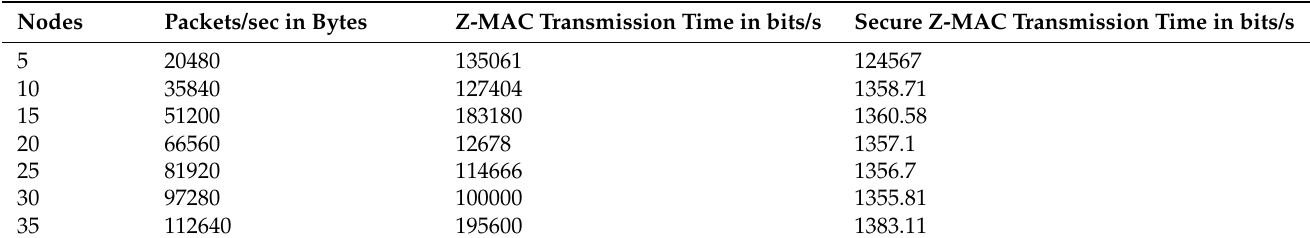
Table 7. Total transmission time during a flooding attack for nodes processed using the secure Z-MAC scheme compared to